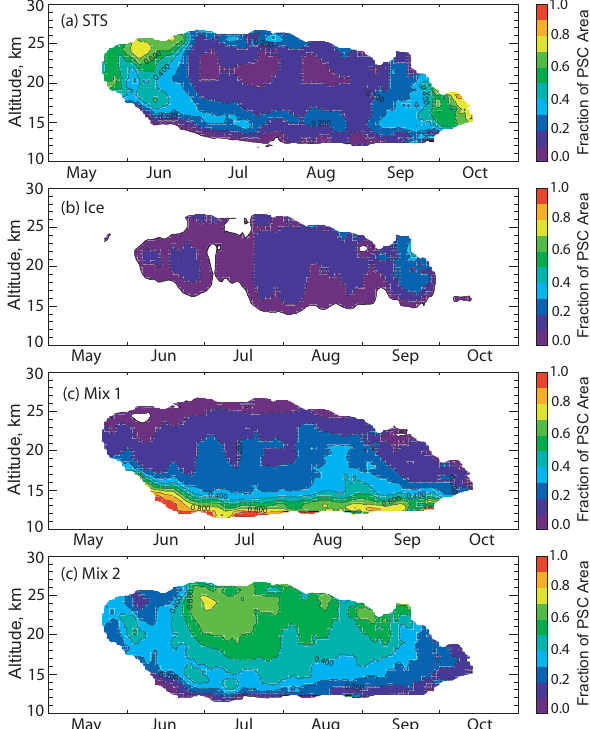
Fig. 13. Time series of three-year mean Antarctic PSC areal cover- age for each of the four composition classes: (a) STS, (b) ice, (c) Mix 1, and (d) Mix 2. The values have been normalized by the total PSC area to show the relative coverage of each composition class as indicated by the color